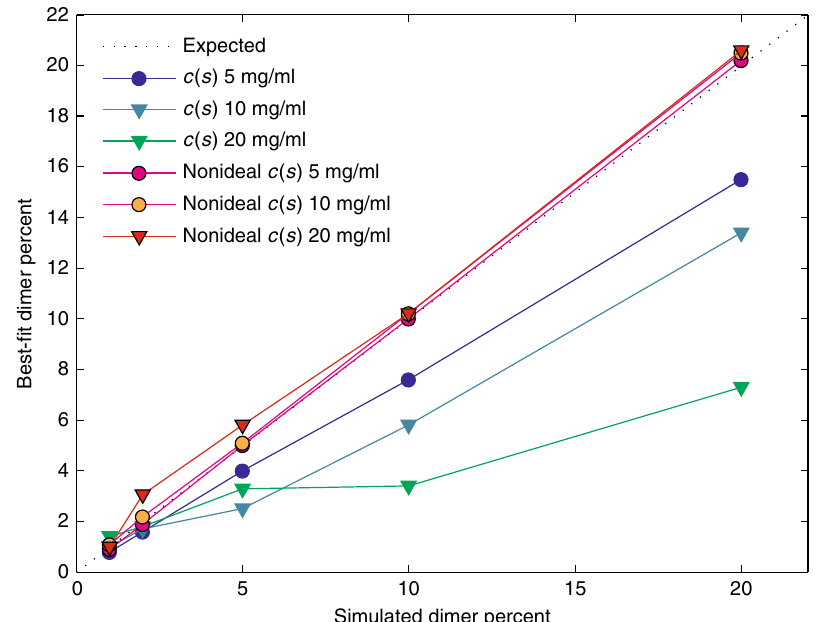
Fig. 4 Impact of Johnston – Ogston effect on the detection of dimer populations. Sedimentation data were simulated for an antibody with different dimer populations at 5, 10, and 20 mg/ml total concentrations. Shown are the estimated dimer fractions from analysis using an empirical fi t with the standard c ( s ) model (blue, cyan, green), and with the c NI ( s 0 ) model accounting for nonideality (red, orange, and magenta). The true dimer fractions are indicated by the dotted gray